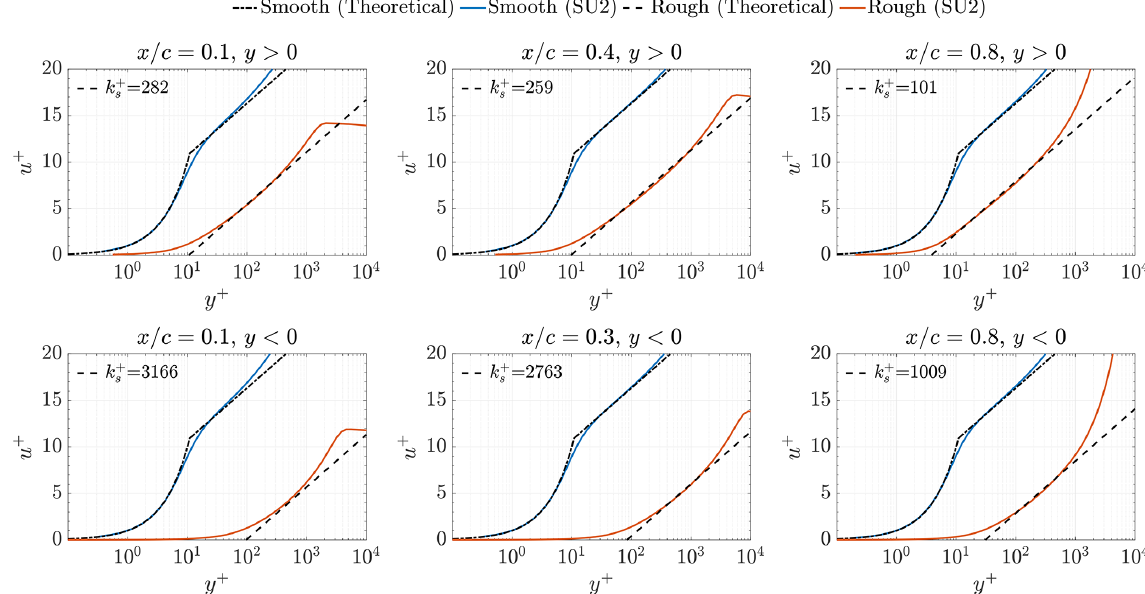
Figure 11. Law of the wall using Boeing extension for the SA turbulence model. NA18 airfoil, α = 0 ◦ , Re = 6 . 6 × 10 6 . Top row: k s /c = 0 . 0005. Bottom row: k s /c = 0 . 005.